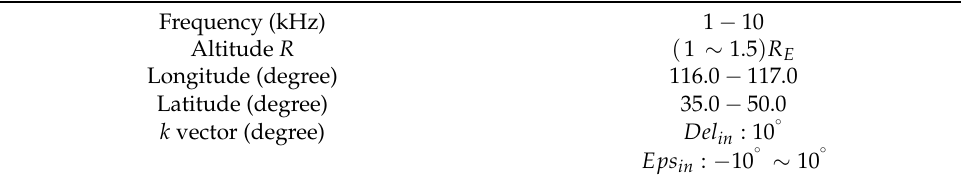
Table 2. Initial conditions of ray path for the second event.